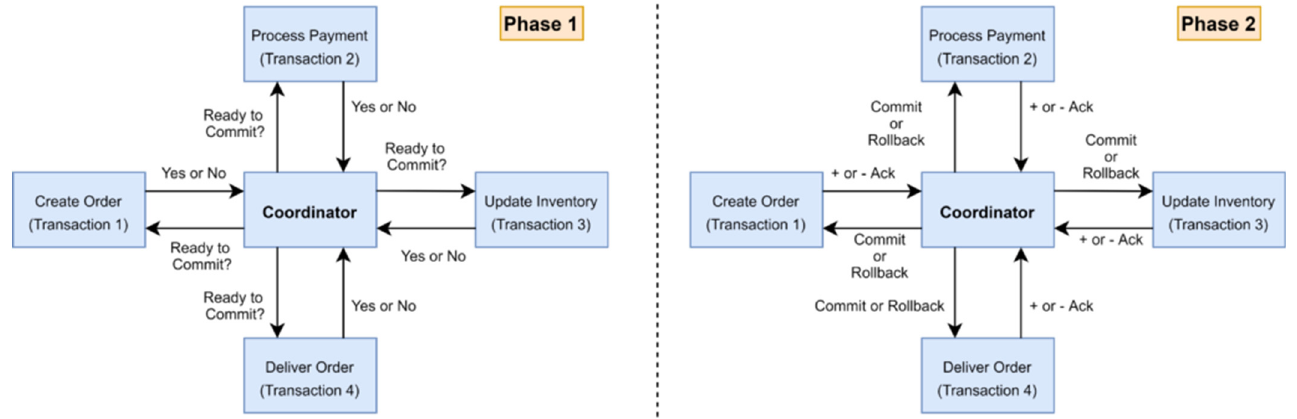
Figure 1. Illustration of the two-phases commit protocol.